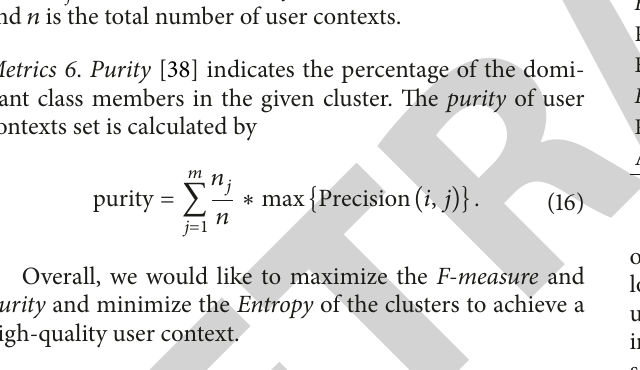
Table 7: The result of two experiments aforementioned in Section 5.1 on using or not using implicit concepts ( 𝛼 = 0.05 and 𝛽 = 0 ). Using implicit concepts Not using implicit